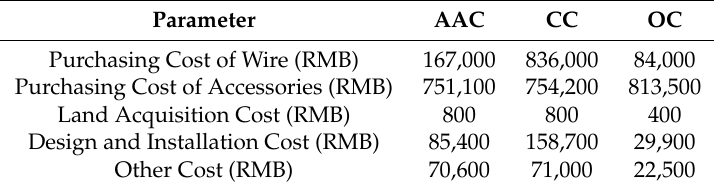
Table 1. Purchasing parameters in Case 1. AAC, aluminum alloy cable; CC, copper cable; OC, overhead conductor.